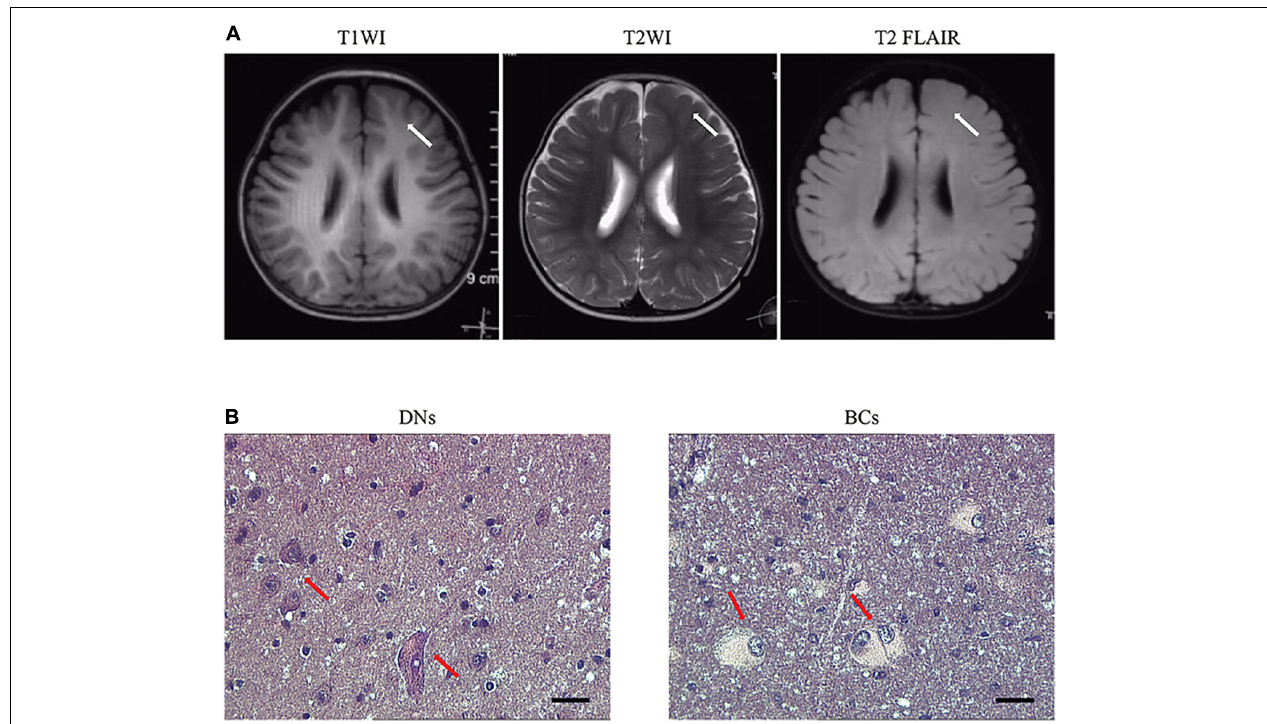
FIGURE 1 | Representative MRI and pathology of patients with RALA c.G482A somatic variant. (A) MRI axial representations of the RALA somatic mutation patient. T1WI, T1-weighed image; T2WI, T2-weighed image; T2 FLAIR, T2 fluid-attenuated inversion recovery. The location of the lesion is indicated by a white arrow. (B) Histopathological results of the patient. Dysmorphic neurons and balloon cells are shown in the red arrow. HE, 10 × 40; DNs, dysmorphic neurons; BCs, balloon